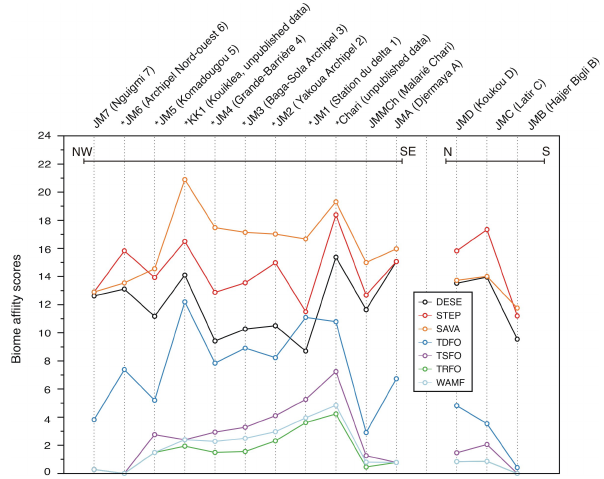
Fig. 5. Biome affinity scores derived from the modern data set, Lake Chad. Pollen counts are from Maley (1972) and from unpublished data (CEREGE). (DESE: desert; STEP: steppe; SAVA: savanna; TDFO: tropical dry forest; TSFO: tropical seasonal forest; TRFO: tropical rain forest; WAMF: warm